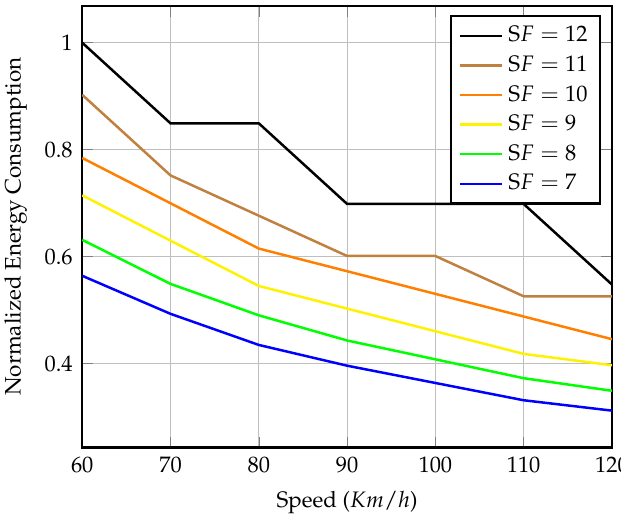
Figure 9. Number of received packets within effective visibility time of different speeds and SF values in the case of perfect gateway arrival synchronization.